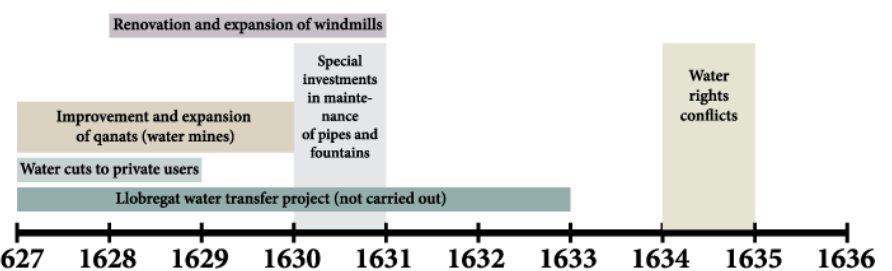
Figure 6. Monthly drought rogation levels in Barcelona, 1601–1650.